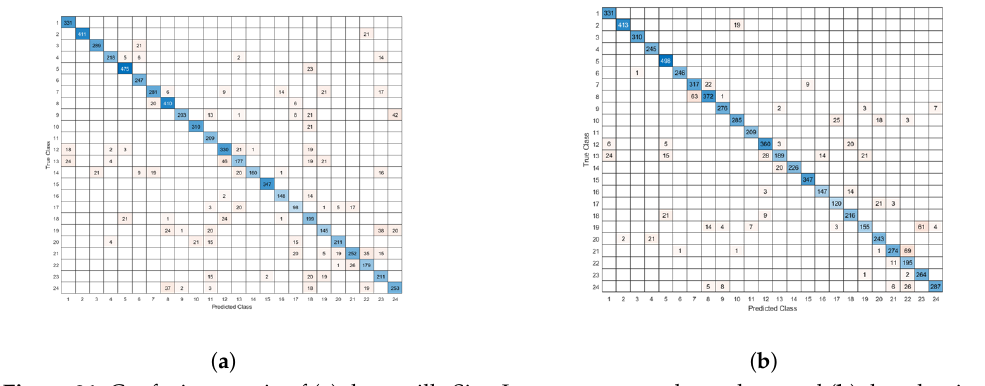
Figure 21. Confusion matrix of ( a ) the vanilla Sign Language network topology and ( b ) the adaptive Sign Language network